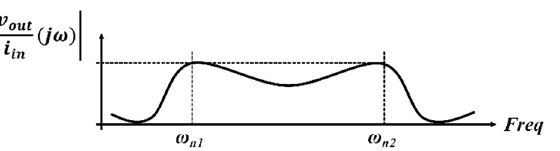
Figure 8. Calculated Z 21 of MCCR (Magnetically and Capacitively Coupled Resonator) with differ- ent ω 2 / ω 1 ratios.